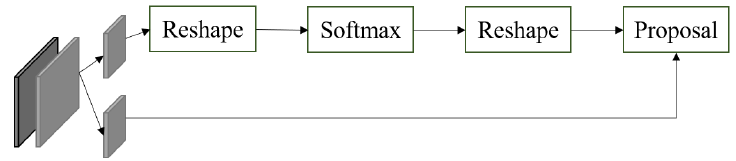
Figure 8. The RPN architecture used in this SiamRPN.